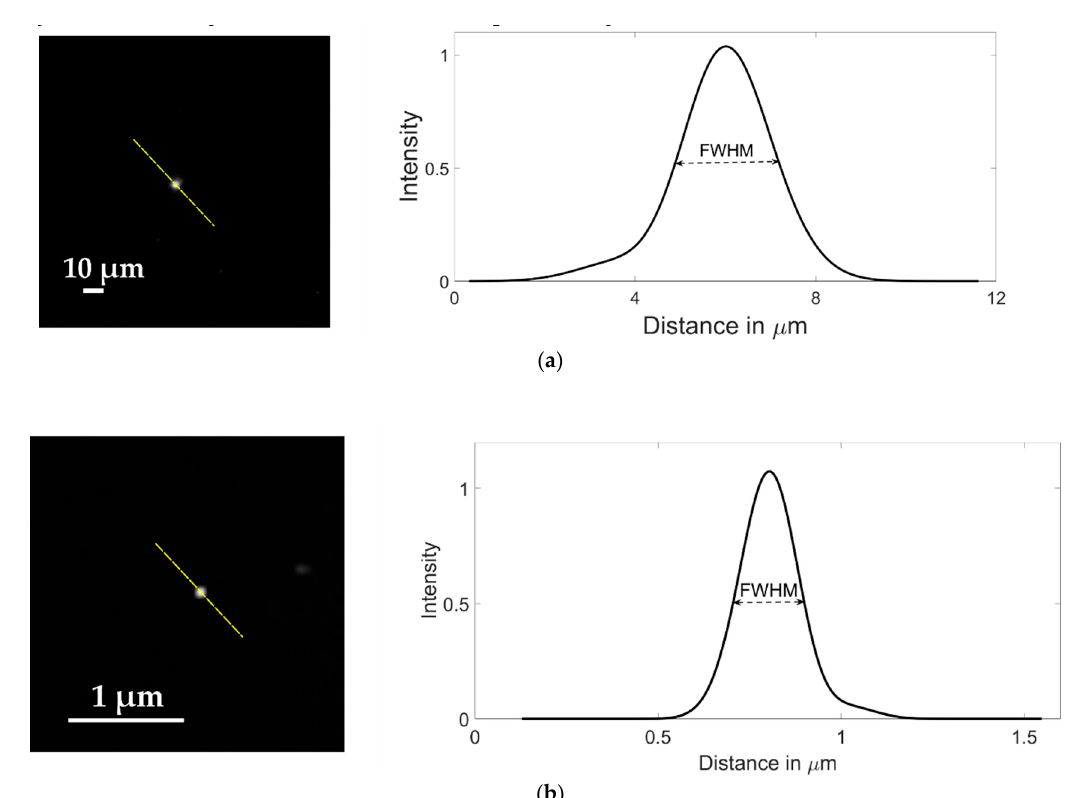
Figure 4. Images of fluorescent microspheres used to estimate the spatial resolution of the imaging system; ( a ) 1.0 μ m diameter microsphere imaged with a Motic CCIS Plan achromatic phase objective UC Ph2 20x objective; ( b ) 100 nm diameter microsphere imaged with an Olympus UPLFLN 100x magnification objective. The graphs represent the Gaussian function that fits the average microsphere profile, taken along the diagonals passing through the highest intensity pixel (dashed lines).